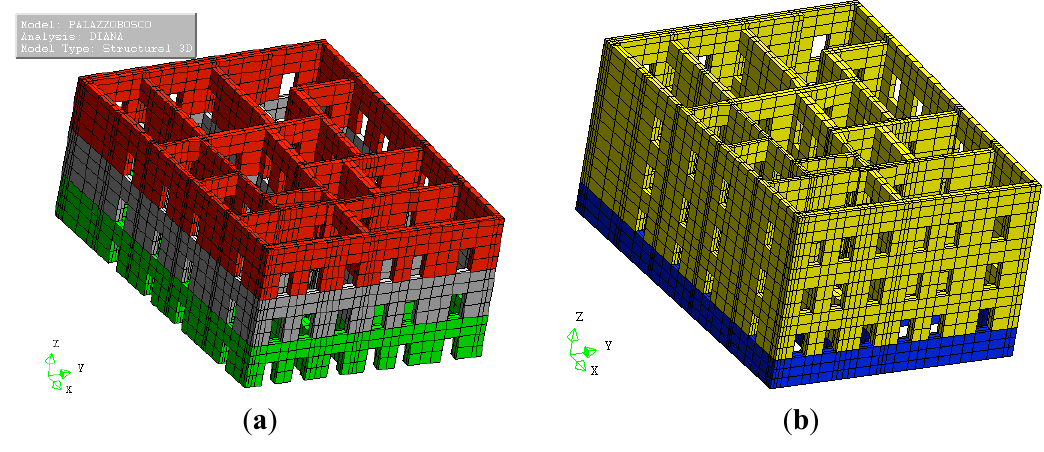
Figure 6. 3D Finite Element (FE) Model of Palazzo Bosco Lucarelli: ( a ) without the underground floor (Model A); ( b ) with the underground floor (Model